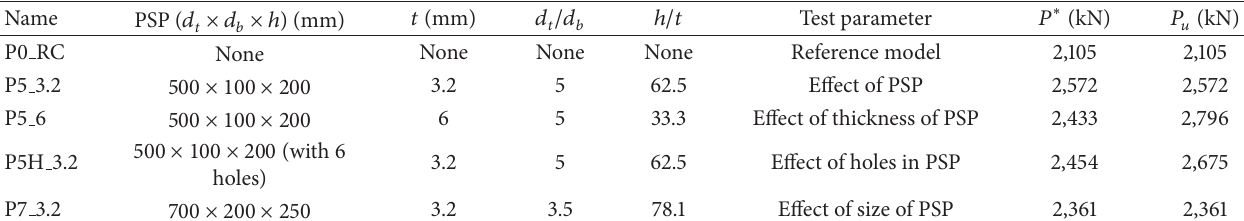
Table 1: Description of test specimens and test results.